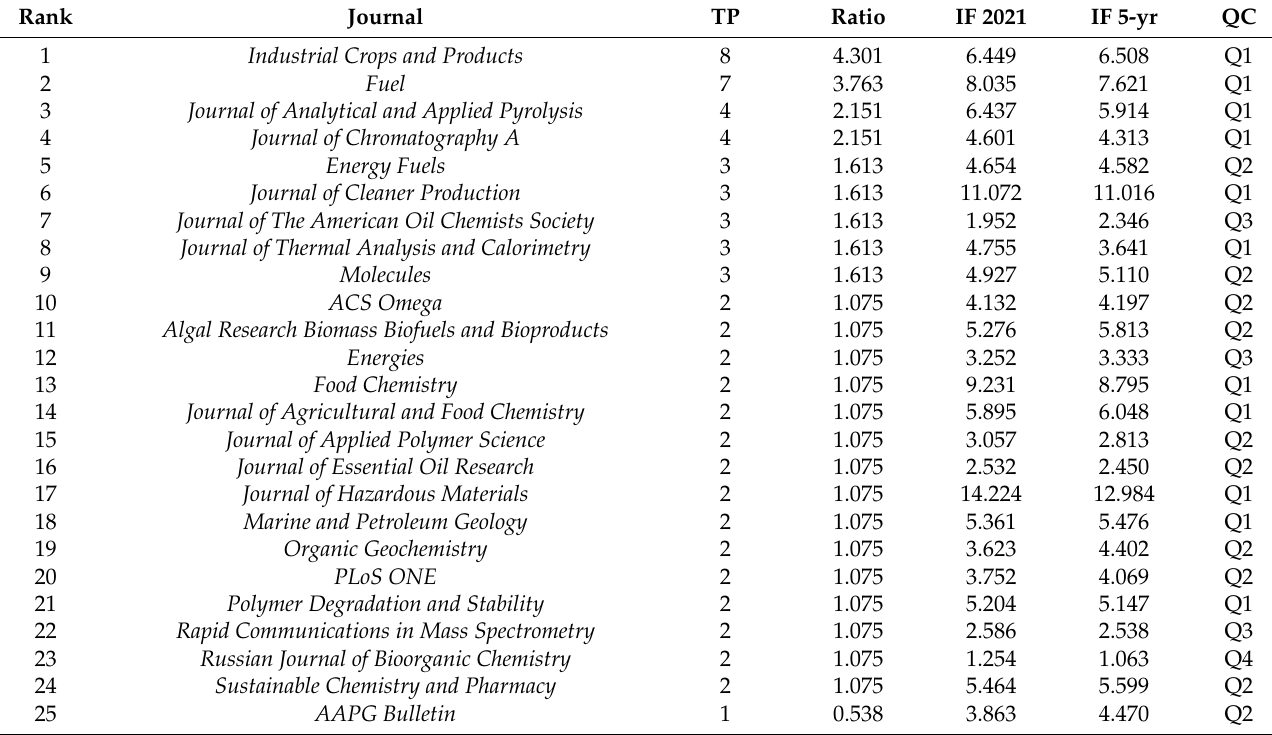
Table 3. The top 25 journals on Web of Science for research on biodiesel production from essential